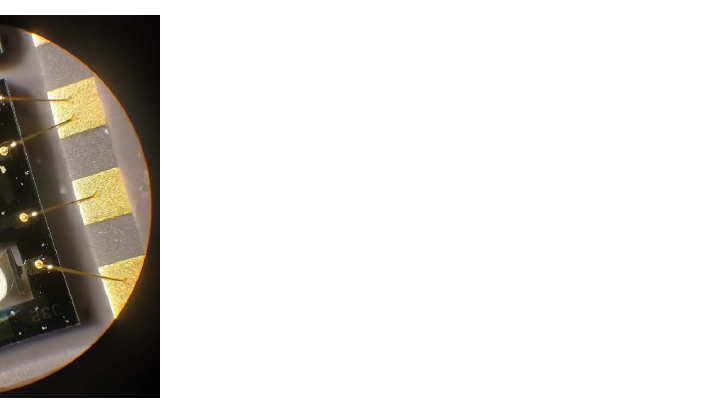
Figure A5. Example MOx sensor surfaces (4 × magnification), bottom sensor is damaged. Table A2. Sensitivity and zero currents for OX-B431 cells, provided by Alphasense.